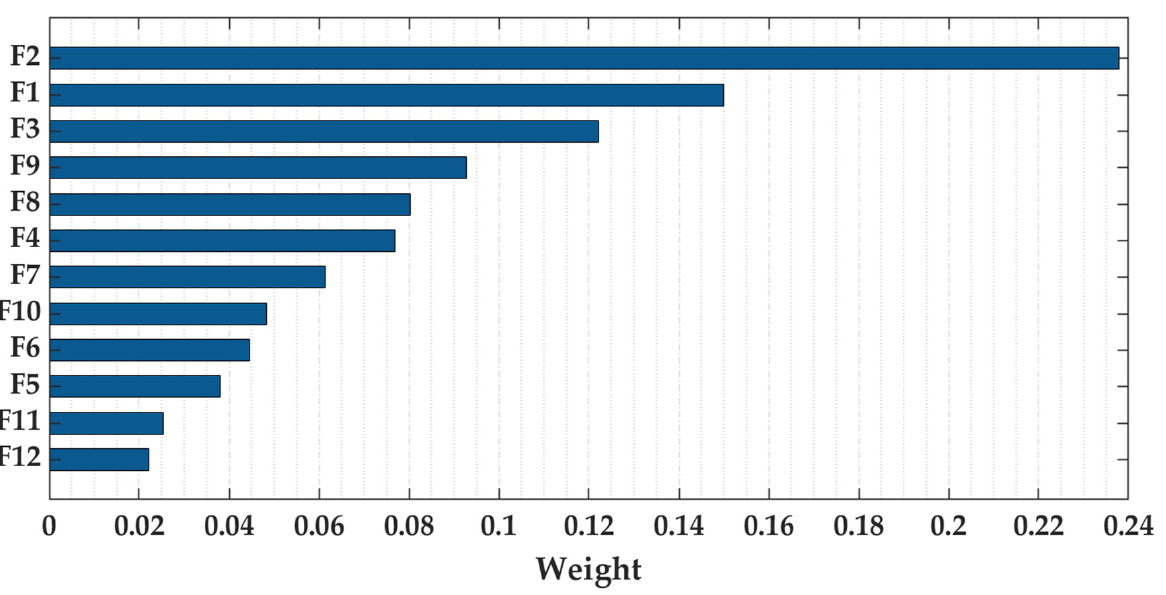
Figure 3. The weight of different features (F) in Table 3 for distinguishing cloudy data and cloud-free data in the training set.